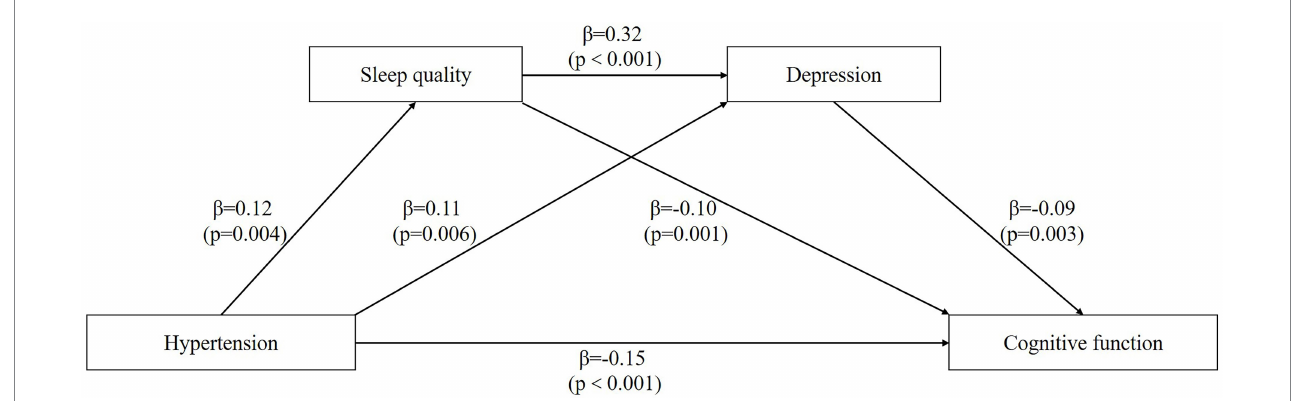
FIGURE 2 The chain mediation model. The chain mediation model shows the effects of hypertension, sleep quality, and depression on the cognitive